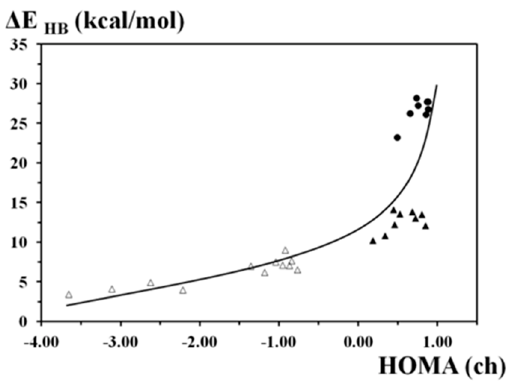
Figure 6. The dependence of the hydrogen bond energy on the aromaticity index of the chelate chain (HOMA(ch)). Dark triangles and circles refer to the tautomeric form OH and the transition state for the compounds with quasi -aromatic hydrogen bonding ( Schiff bases); light triangles stand for the OH tautomeric form for the compounds without π -electronic coupling ( Mannich bases). Ref. [29] – Reproduced by permission of The Royal Society of Chemistry.